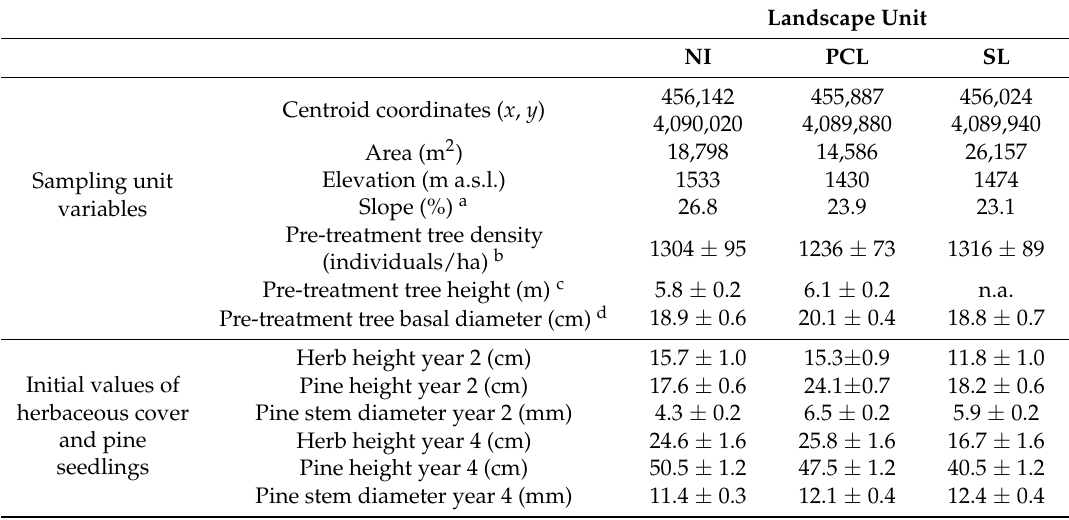
Table 1. Characteristics of the landscape units used in this study and initial values of herb and pine seedlings growth parameters for each of these